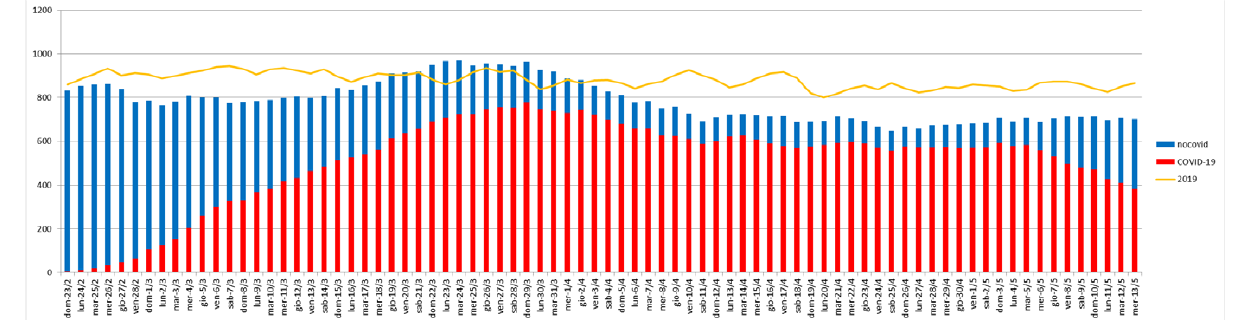
Figure 1. Trend of the number of COVID-19 admissions and corresponding deaths per day (red line).